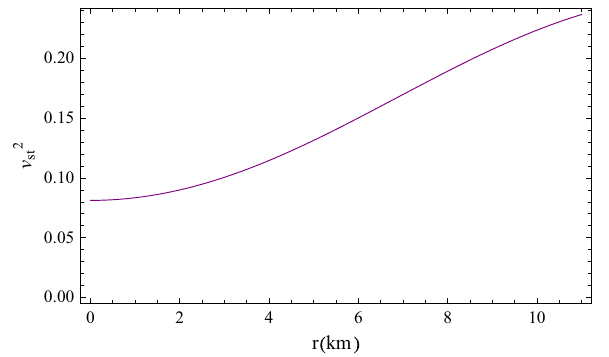
Fig. 10 Variation of v 2 st with r of PSR J0348+0432